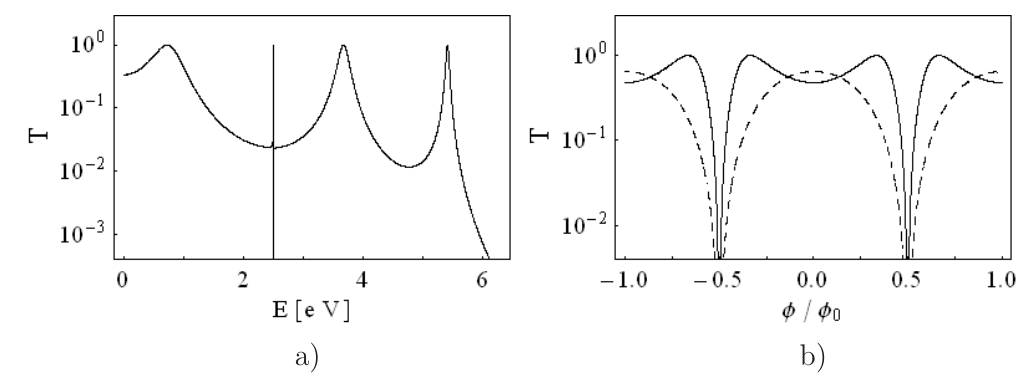
Fig. 3 (a) Transmission-energy function for B = 40 T and (b) transmission-magnetic flux dependences (for E = 0 . 5 eV – solid line, E = 1 . 0 eV – broken line) for x-bridged device.